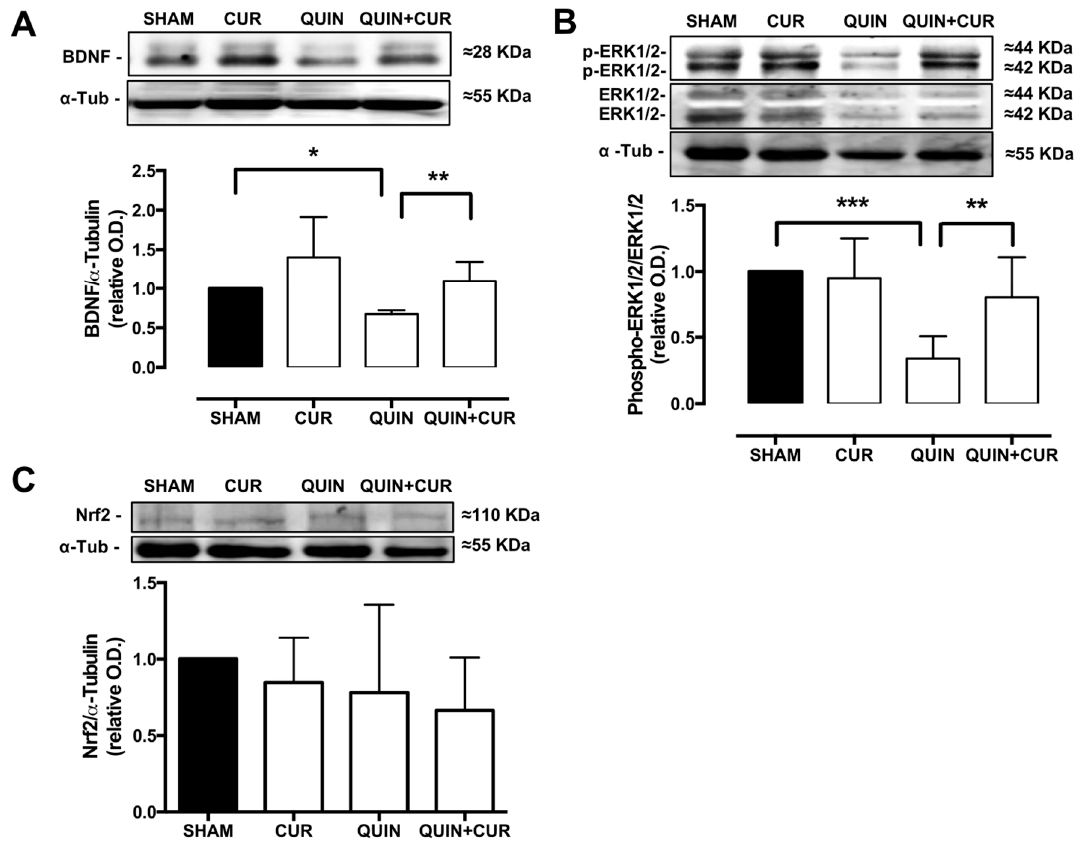
Figure 5. Effect of quinolinic acid (QUIN) and curcumin (CUR) on brain-derived neurotropic factor (BDNF), phosphorylated mitogen activated protein kinase (MAPK) protein extracellular signal-regulated kinase-1/2 (phospho-ERK1/2), and nuclear factor erythroid 2-related factor 2 (Nrf2) levels. Representative blots (upper panels) and quantification of the optical density (O.D.) ratio (lower panels) of ( A ) BDNF, ( B ) phospho-ERK1/2, and ( C ) total Nrf2 in the striatum are presented. Data are expressed as mean ± SEM (n = 3). * p < 0.05, ** p < 0.01, and *** p < 0.001.